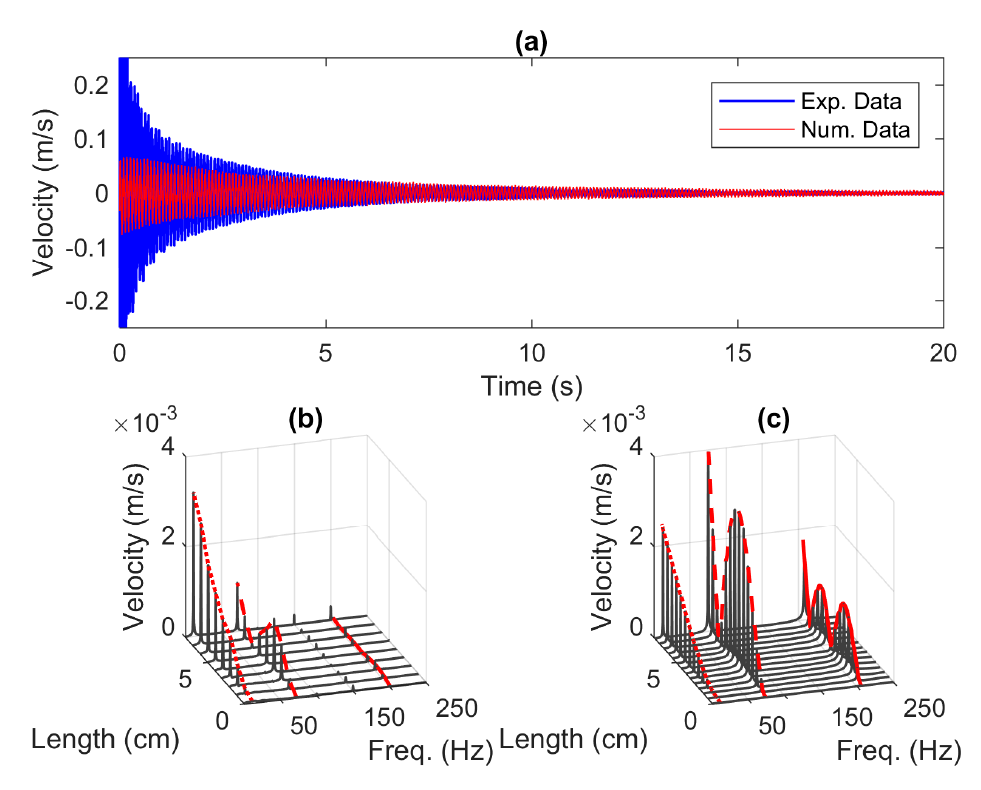
Figure 5. ( a ) The time series of velocity at x = 8 cm, and the 3D plot of velocity in various frequency and beam length of ( b ) the experimental model and ( c ) the numerical model.